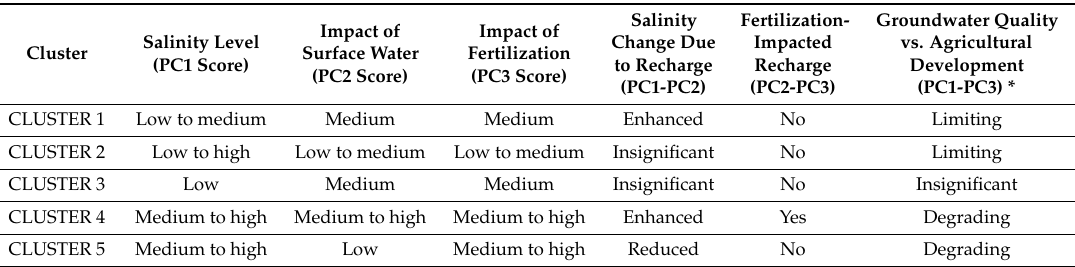
Table 4. Main characteristics of the five clusters with regard to salinity level and impacts of irrigation and fertilization.